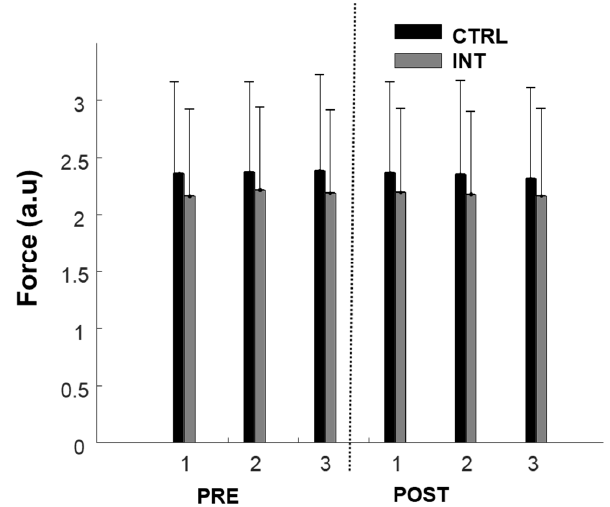
Figure 2. Force production during 10% maximum voluntary contractions (MVCs) pre- and post-intervention for the control group (black) and intervention group (grey). 1, 2, and 3 represent repetitions of contraction consecutively.